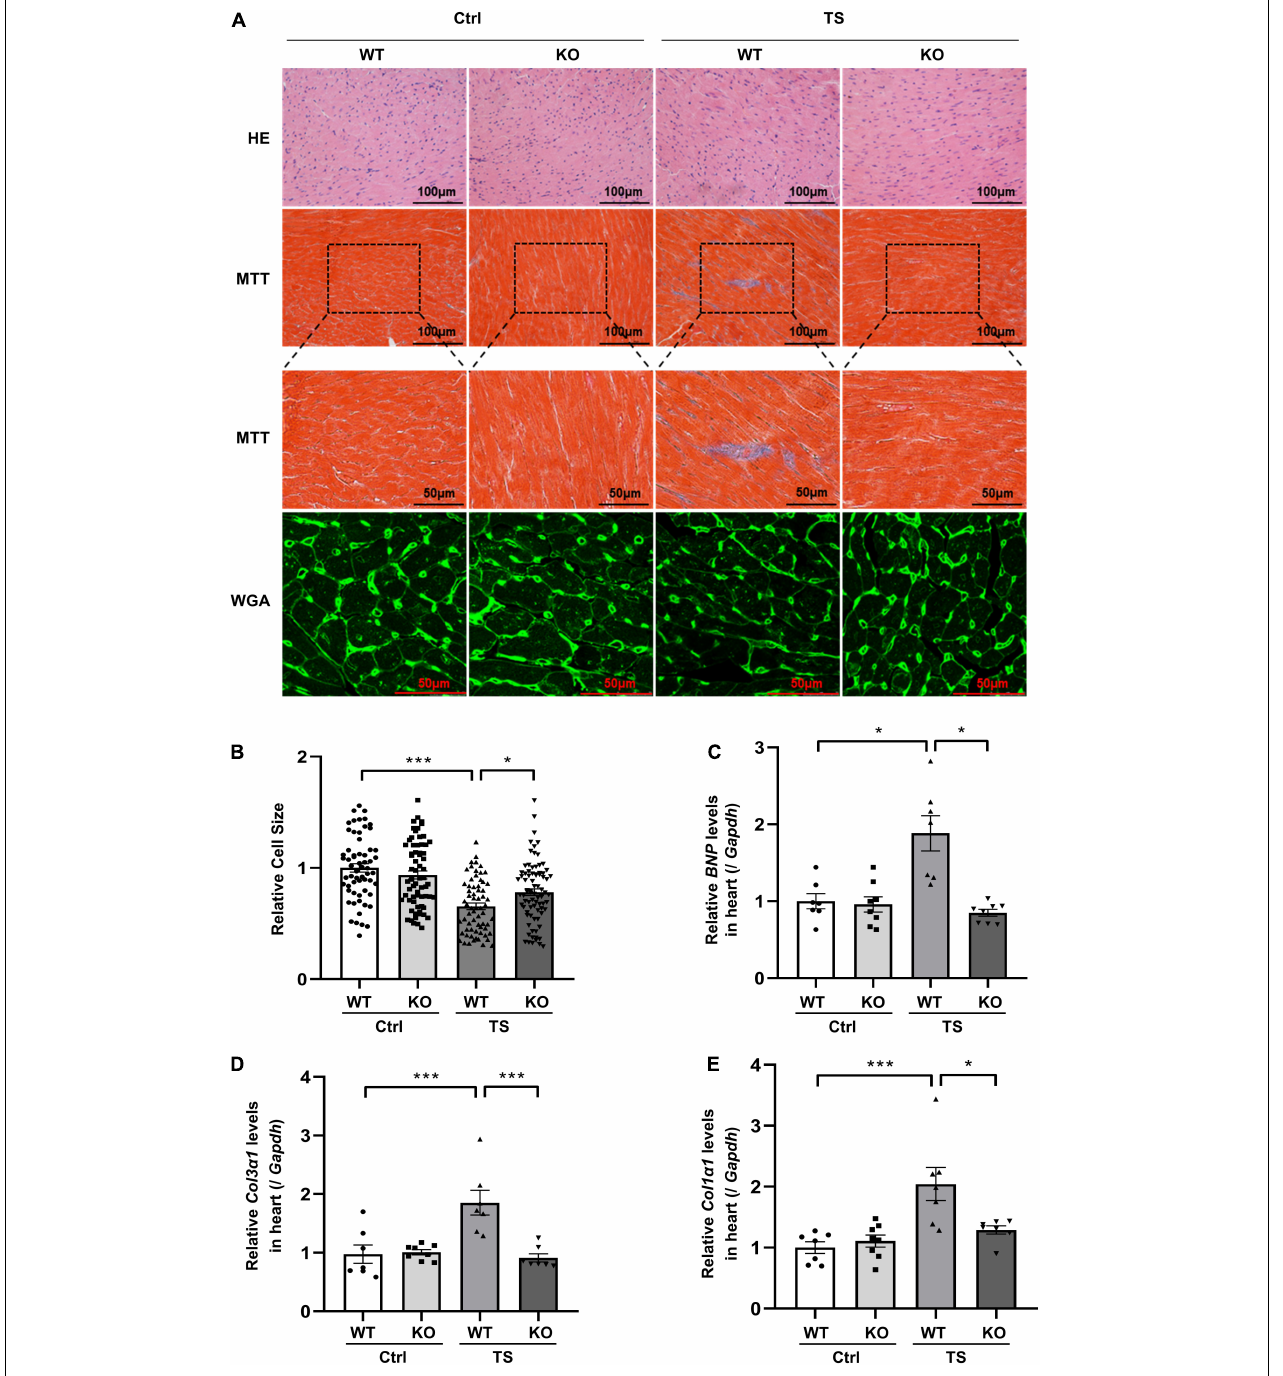
FIGURE 4 | WW domain-containing E3 ubiquitin protein ligase 1 knockout protects against simulated microgravity induced-cardiac atrophy. (A) Hematoxylin and eosin (H&E)-stained sections of the hearts from WT and WWP1 KO mice after 6 weeks of tail suspension. Sections of the hearts are stained with Masson trichrome (MTT) to detect fibrosis (blue). Wheat germ agglutinin (WGA) staining is used to demarcate cell boundaries. (B) The cardiomyocyte cross-sectional area was measured from 7- µ m-thick heart sections that have been stained with WGA by ImageJ software (NIH). Only myocytes that were round were included in the analysis. (C–E) The mRNA levels of BNP , Col1 α 1 , and Col3 α 1 were analyzed by Q-PCR from WT and WWP1 KO mice after 6 weeks of tail suspension. The relative abundance of transcripts were quantified and normalized to Gapdh . Data represent the means ± SEM, * P < 0.05, ** P < 0.01, *** P < 0.001. Col1 α 1 , alpha-1 type I collagen; Col3 α 1 , alpha-1 type III collagen; BNP, brain natriuretic peptide; Q-PCR, real-time quantitative polymerase chain reaction.